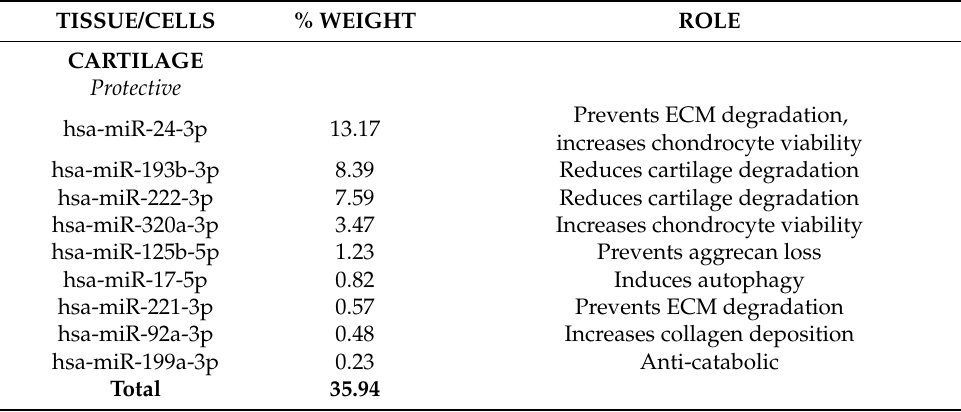
Table 5. EV-miRNAs involved in homeostasis of OA-affected tissues and cells.